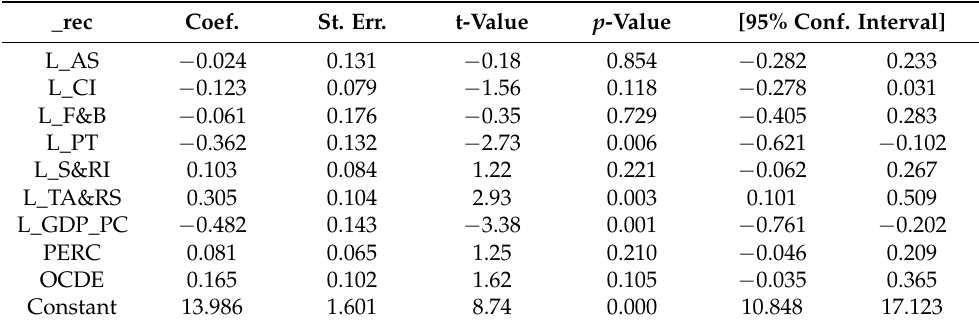
Table A6. Panel data estimations of the explanatory variables of tourism receipts (in logarithm) for the countries in the sample. Random effects panel.